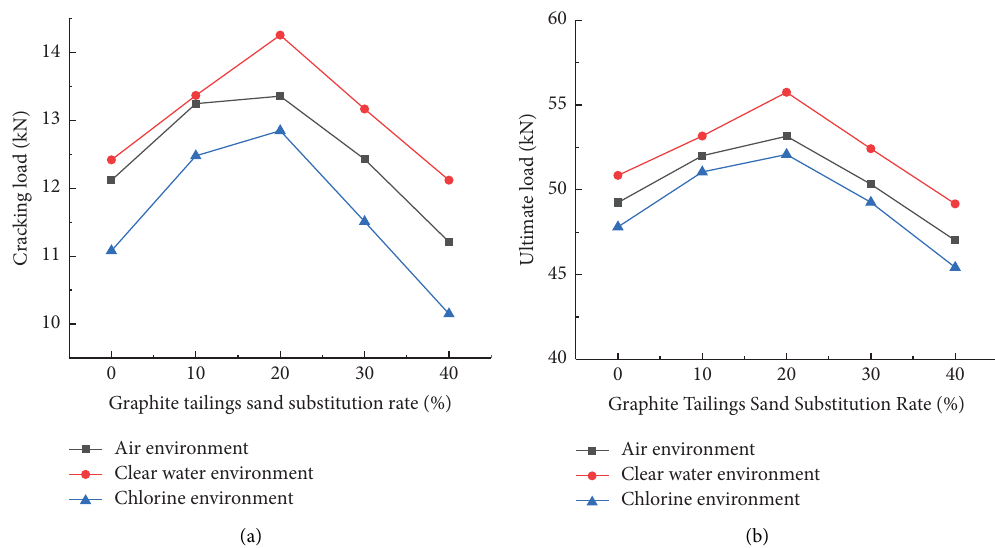
Figure 5: Infuence of graphite tailing sand replacement rate on cracking load and ultimate load of test beam. (a) Cracking load and (b) Ultimate